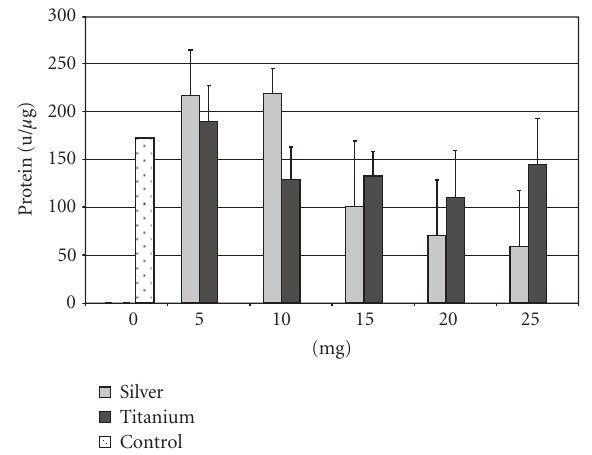
Figure 3: MTT rate of the SAOS cell line after supplementation of 5–25 mg silver or titanium.